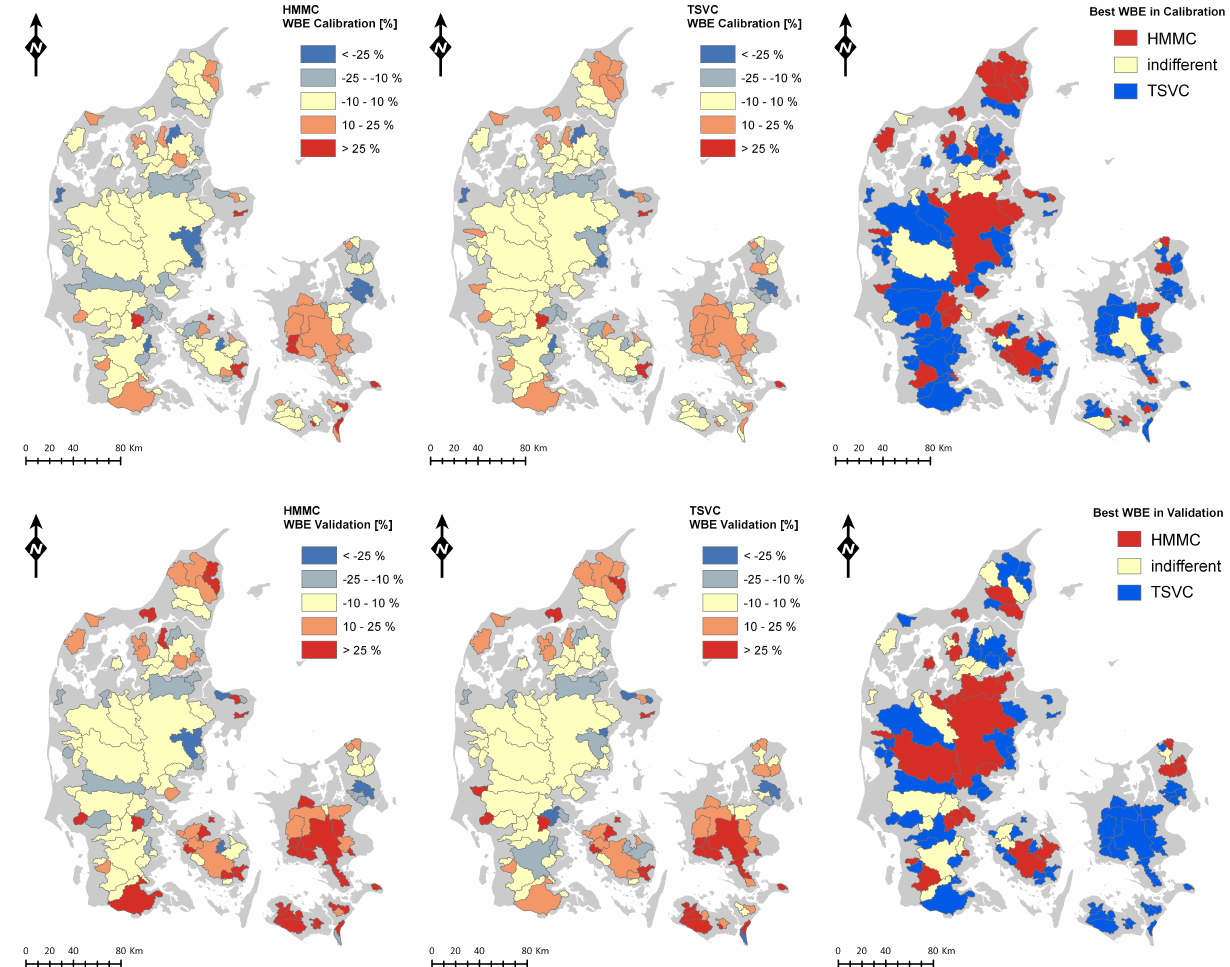
Fig. 11. Distributed map of model performance for WBE for both models during calibration and validation.